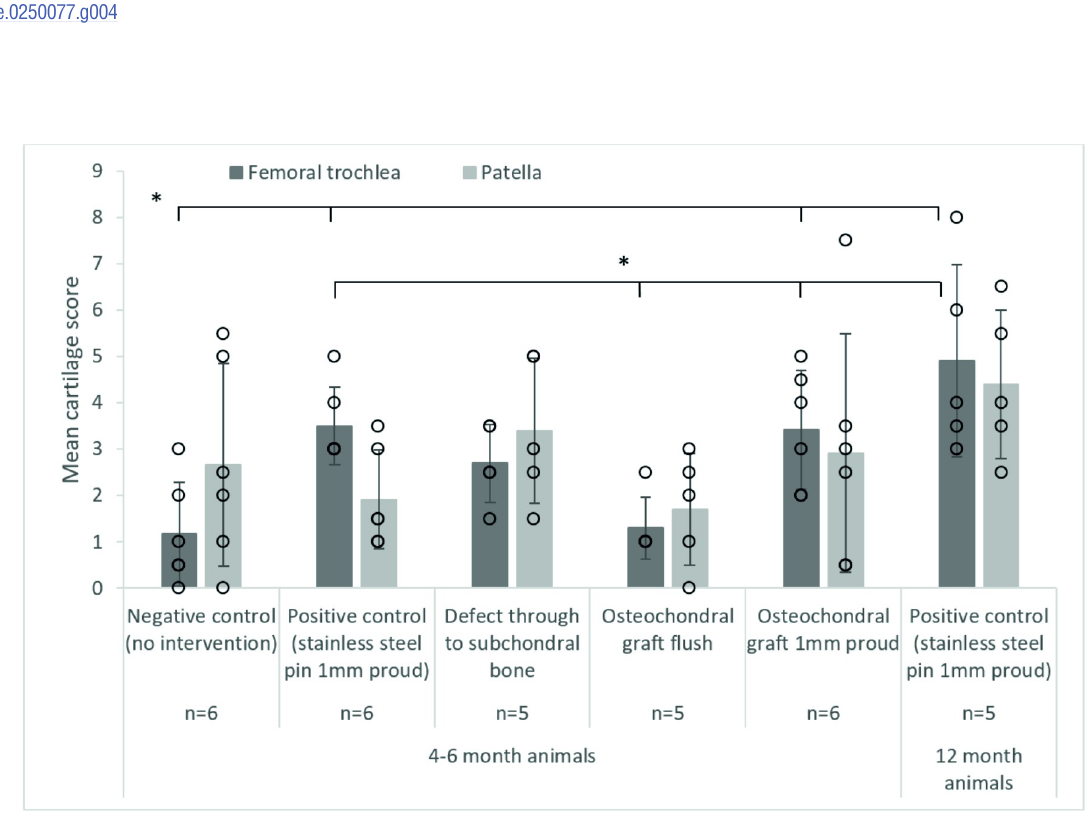
Fig 5. Mean ( ± SD) cartilage score on the patella and femoral trochlea after 3 hours (10,800 cycles) wear simulation, � denotes p < 0.05, there were no significant differences between patella groups. The data points from all experimental groups have been overlaid as a dot plot.